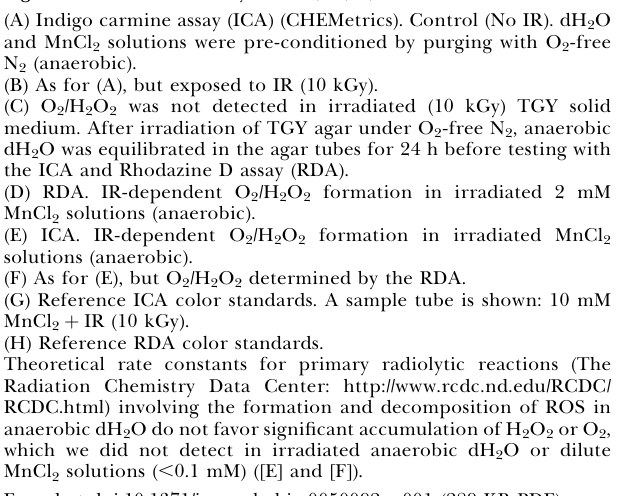
Figure S3. LM, TEM, and XRF Element Distribution Maps of D. radiodurans (A) LM showing TEM grid-locations of diplococcus (group of two cells) no. 109 and no. 110. (B) No. 109. (C) No. 110. D. radiodurans (ATCC BAA-816) diplococci were harvested from a mid-logarithmic culture (OD 600 0.3) in